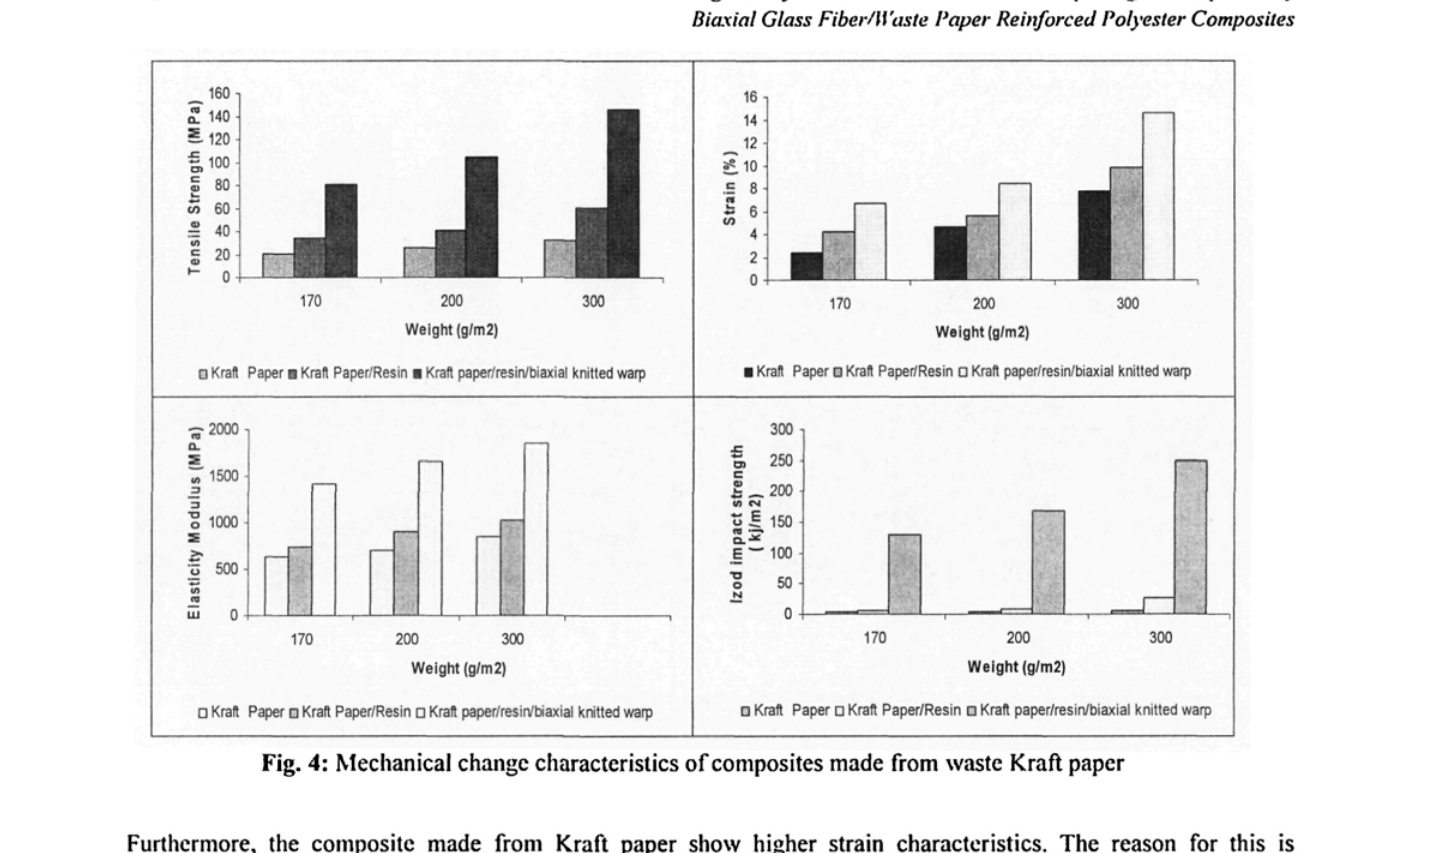
Fig. 4: Mechanical change characteristics of composites made from waste Kraft